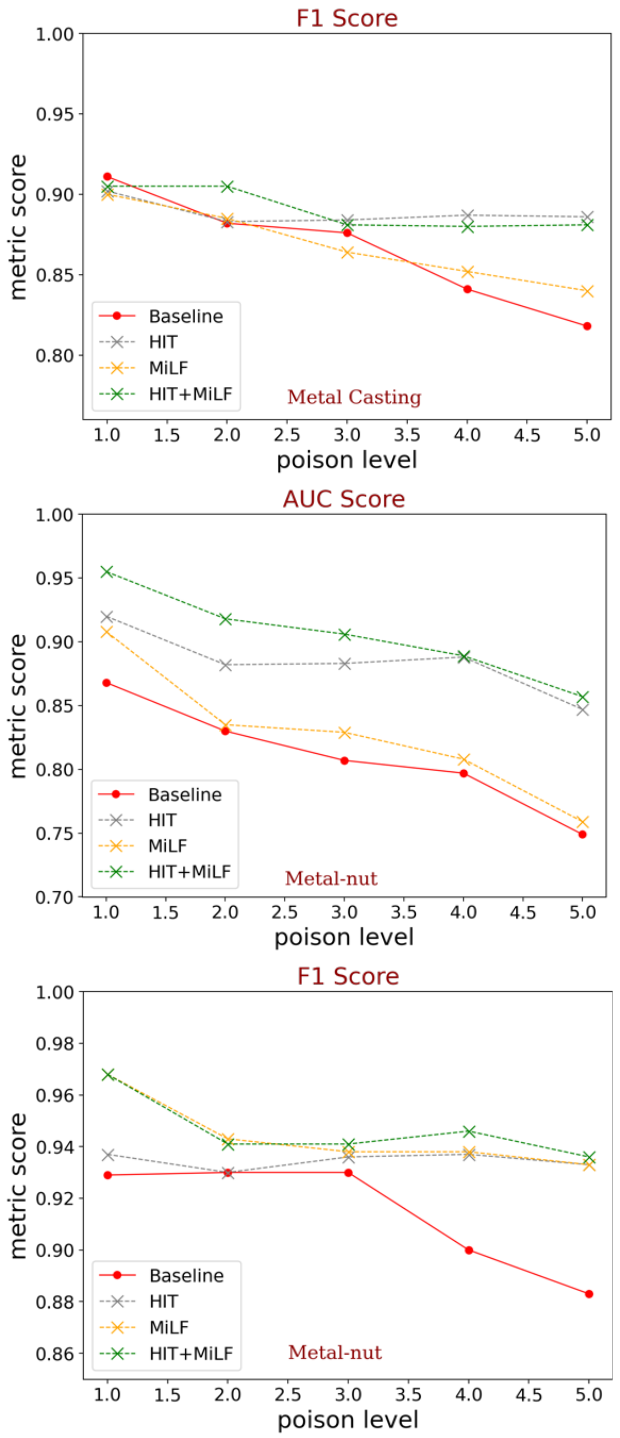
Figure 7. Comparison results of the model before and after implementing our proposed idea across various levels of poison sample on testing data. Although the trend line decreases as poison data increases (up to 50%), our proposed model is still more resistant against poison data and more competitive than baseline models as shown in Metal Casting and Metal-nut subfigures.